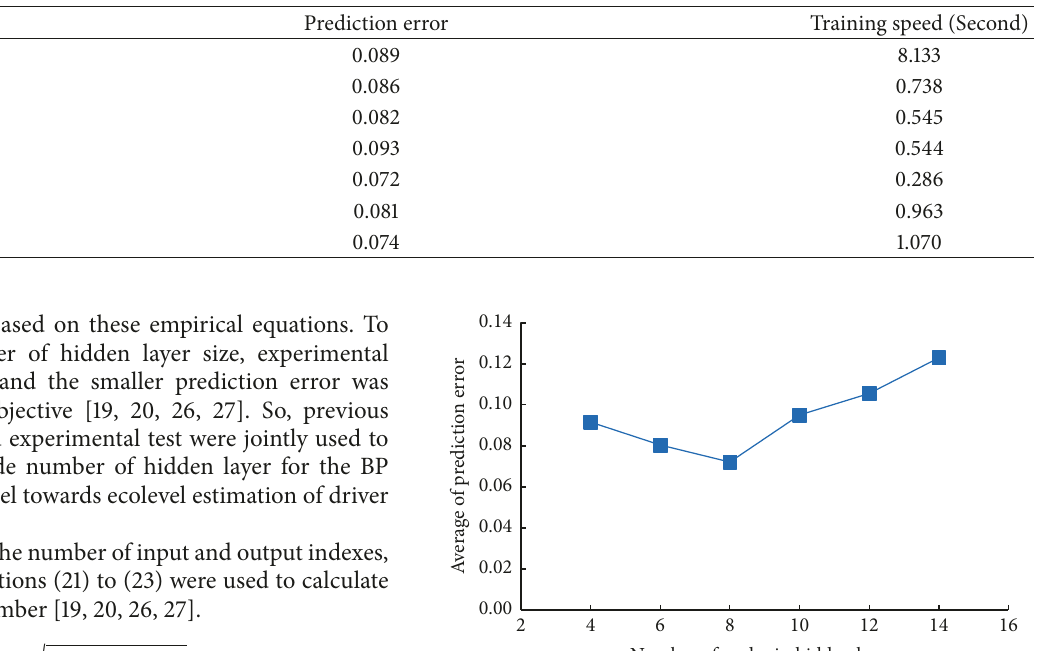
Table 2: Prediction error and training speed corresponding to different training functions.